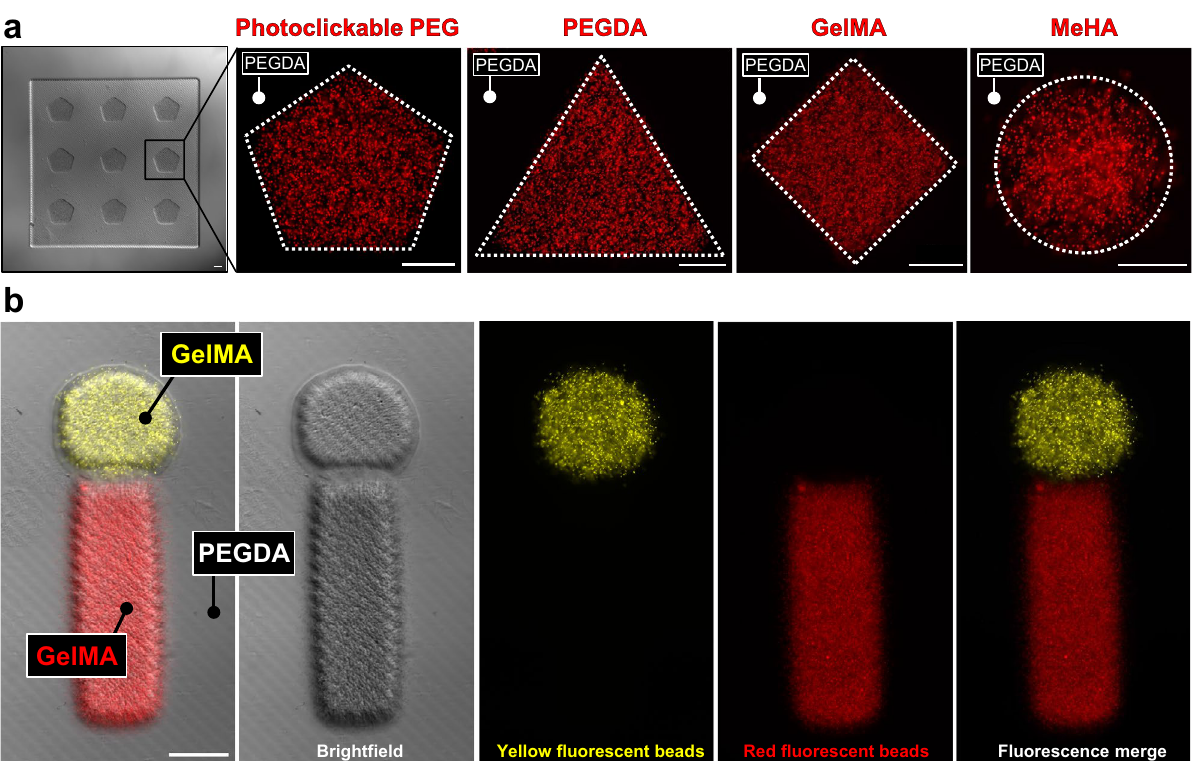
Figure 2. Integration of multiple bioinks. ( a ) Multi-material stereolithography is compatible with a range of bioinks, including synthetic polymers (photoclickable PEG, PEGDA) and naturally derived polymers (MeHA, GelMA). In each example, a geometrically arrayed feature layer with encapsulated fluorescent beads was printed atop a square PEGDA base. ( b ) Monolithic integration of 3 bioinks, highlighting successful spatial segmentation with few if any beads off-target. All scale bars = 250